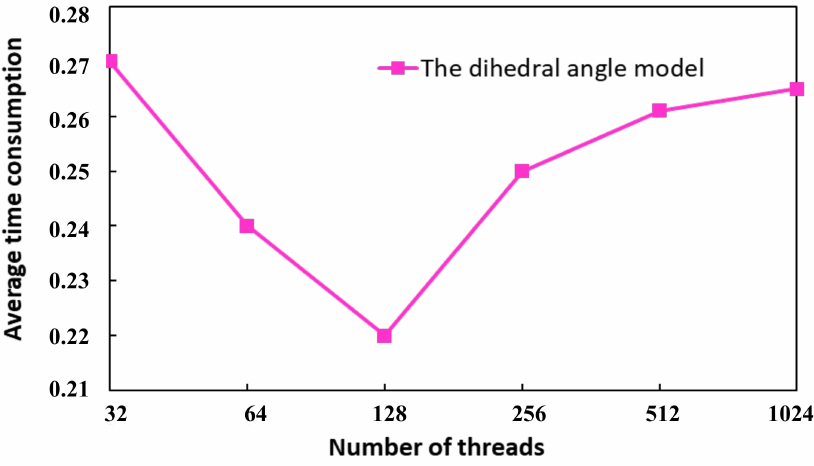
Figure 8. Thread